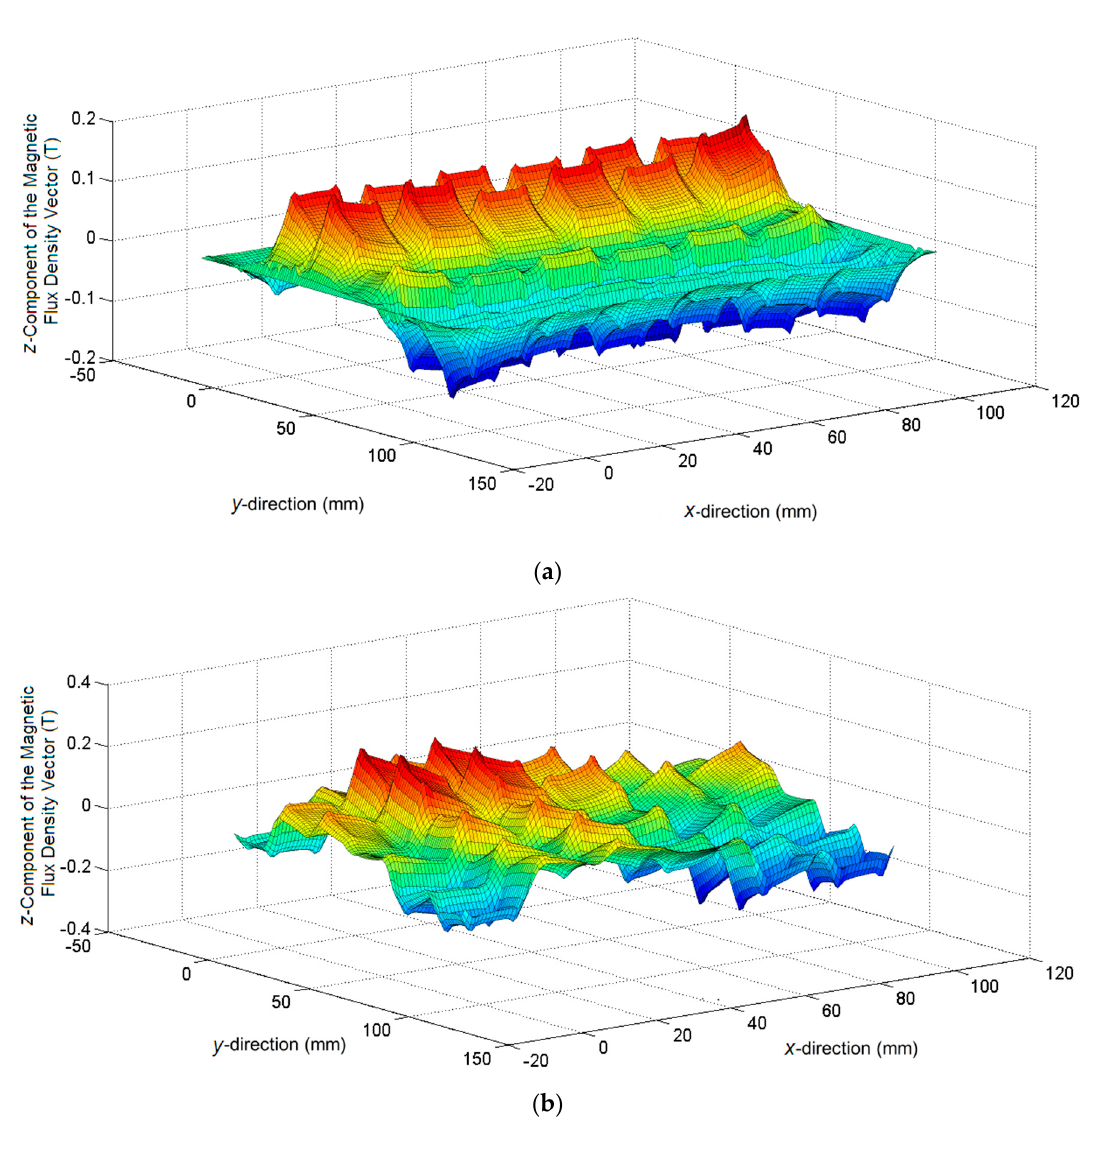
Figure 4. Surface plot of the normal component of the magnetic flux density in the air-gap, case 1: ( a ) with only y -winding fed with voltage; ( b ) with x and y -windings fed with voltage.